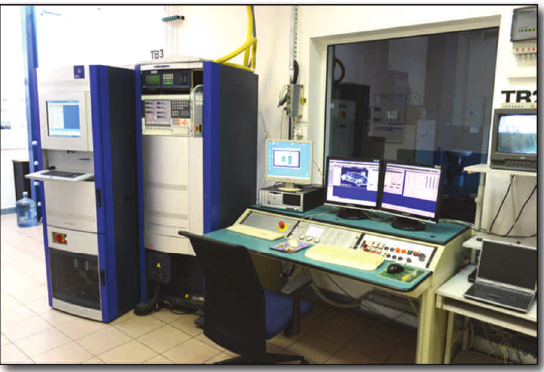
Fig. 2. A set of analysers AMA i60 R2 and CEB II